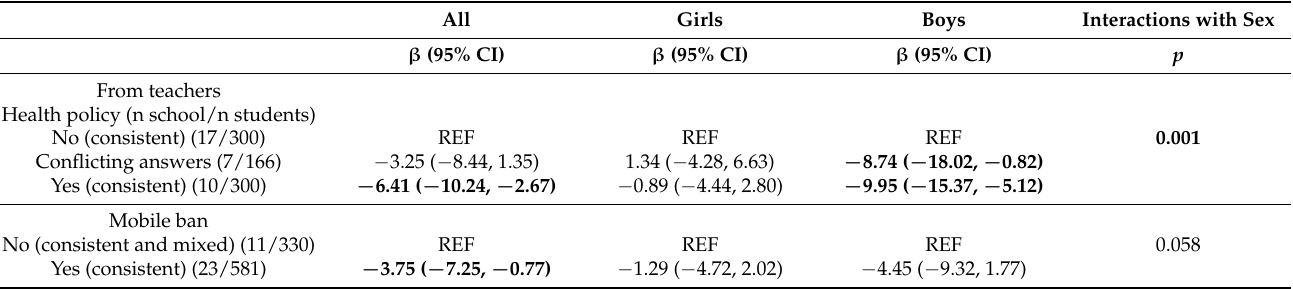
Table 4. Associations between the school environment and the participants’ sedentary time in minutes during school time. All Girls Boys Interactions with